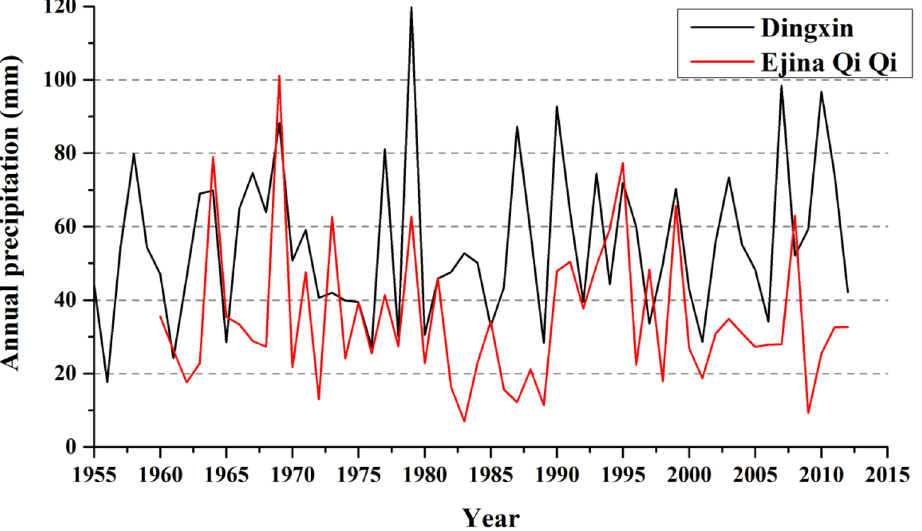
Figure 2. Variations in annual precipitation in Ejina Qi and Dingxin